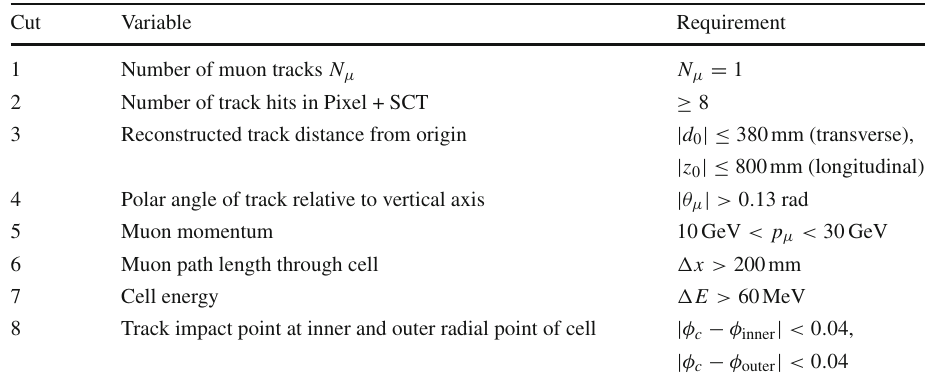
Table 3 Selection criteria applied to the event, track, and muon used in the cosmic muons analysis. A description and motivation of each cut can be found in the